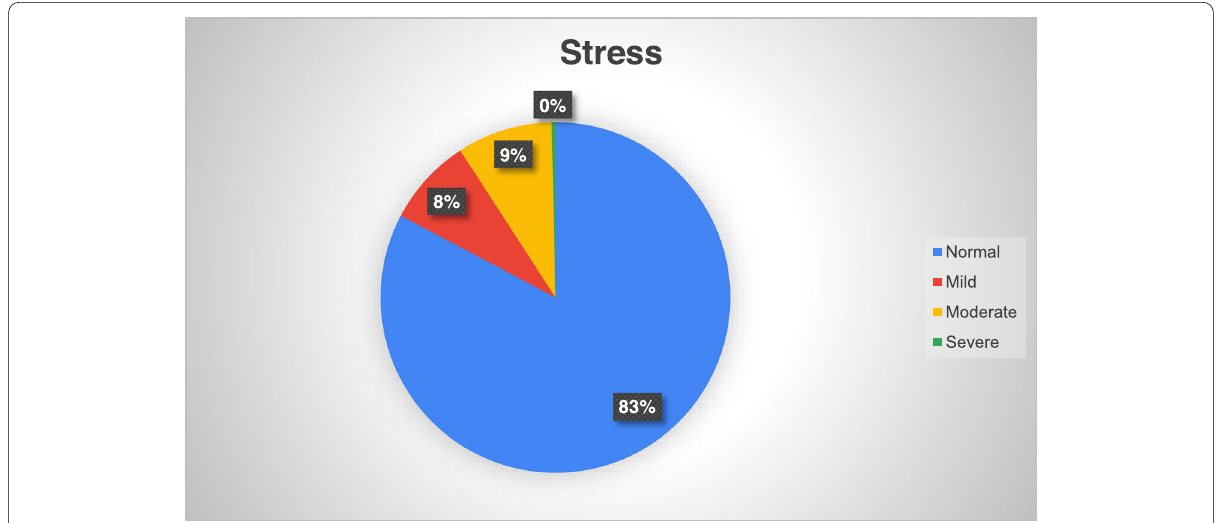
Fig. 3 Prevalence and severity of stress among the healthcare professionals using DASS-21 ( N